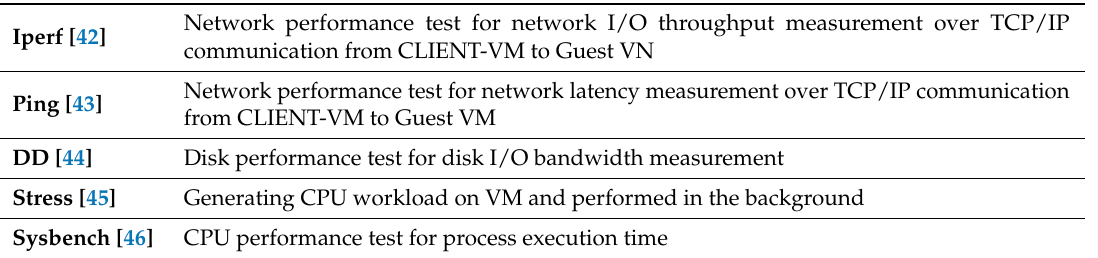
Table 2. Benchmark